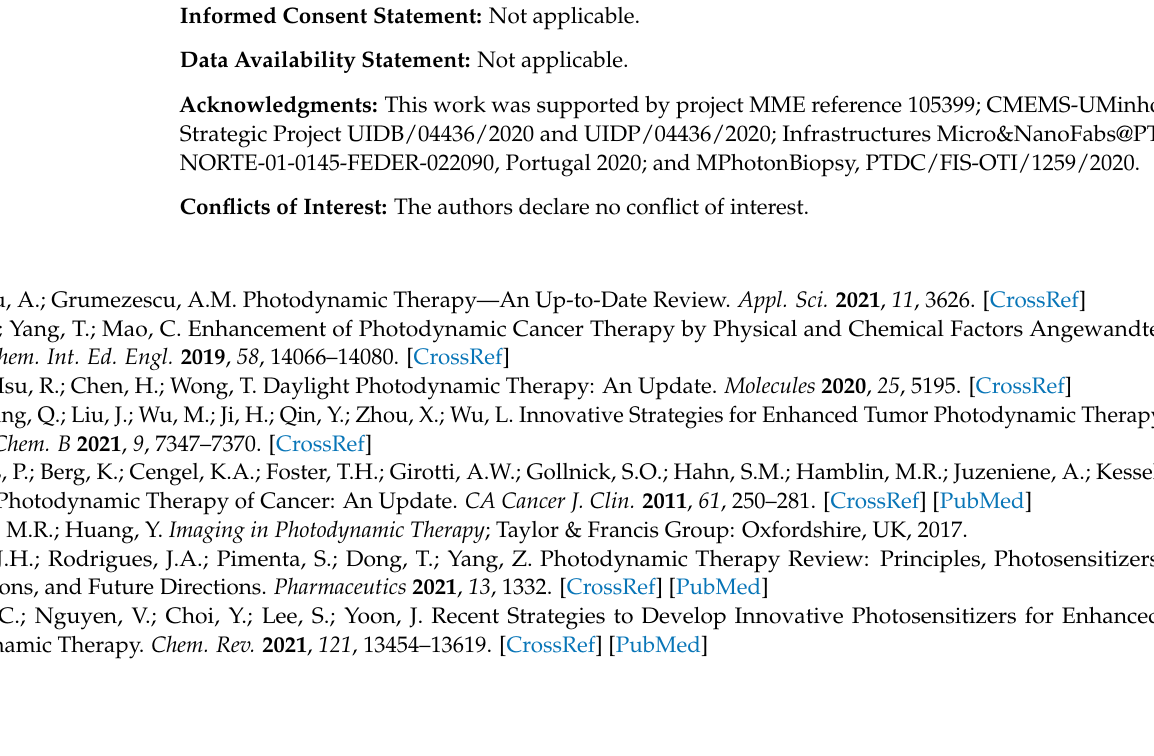
Electric field Magnetic field